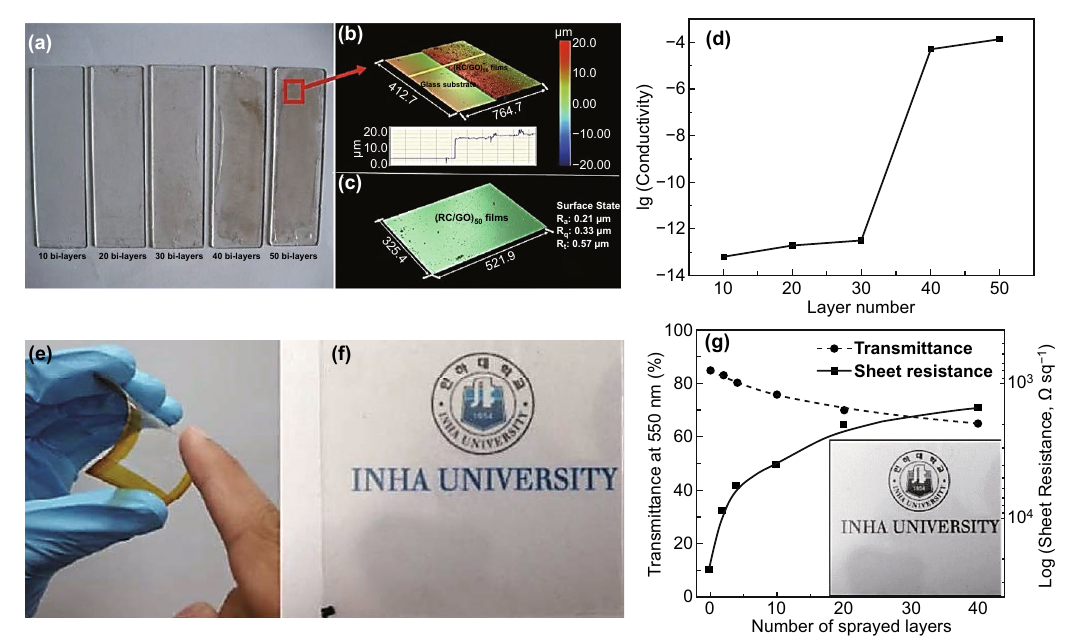
Fig. 15 a (RC/GO) n ultrathin film surface topography of different bilayers ( n = 10–50). b, c Thickness and roughness of (RC/GO) 50 nanocom- posite film on a glass substrate. d The layers’ influence on the electrical conductivity of (RC/GO) n composite film. Reproduced with permission from Ref. [105] Copyright © 2012, Chinese Materials Research Society, Production and hosting by Elsevier B.V. e , f Flexibility and transpar- ency of CNCs-rGO hybrid film. g The sprayed CNCs-rGO layers resistance via conductivity measurements. Reproduced with permission from Ref. [146] Copyright © 2014 WILEY ‐ VCH Verlag GmbH & Co. KGaA,